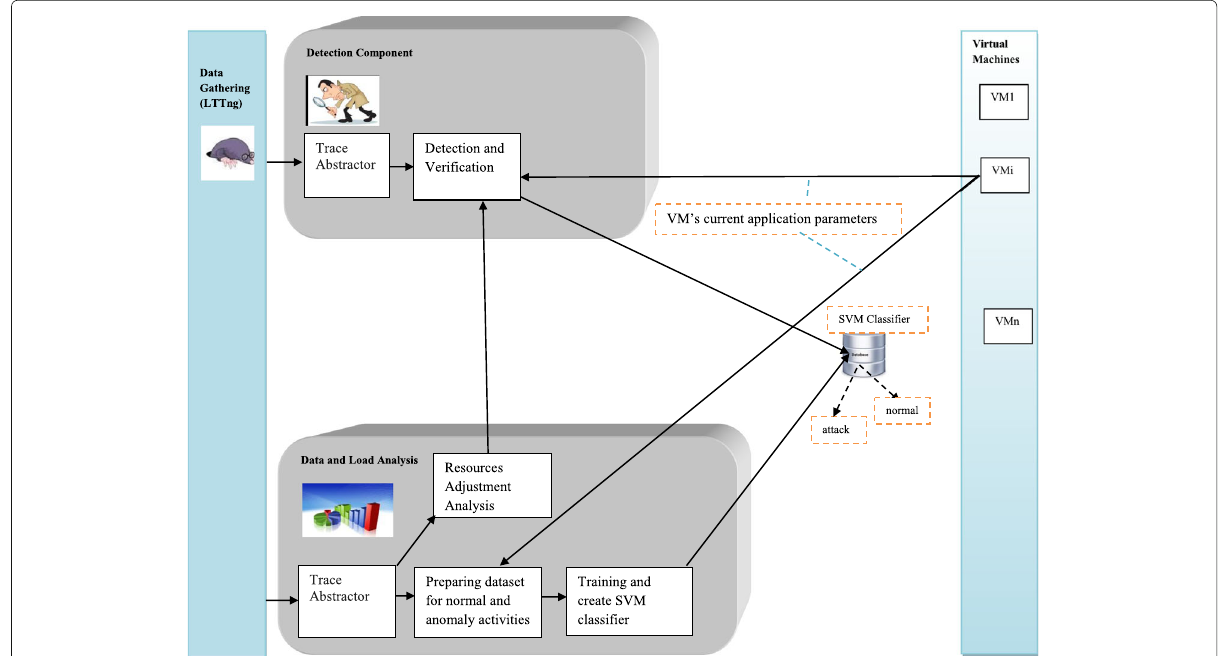
Fig. 1 Architecture of the Proposed